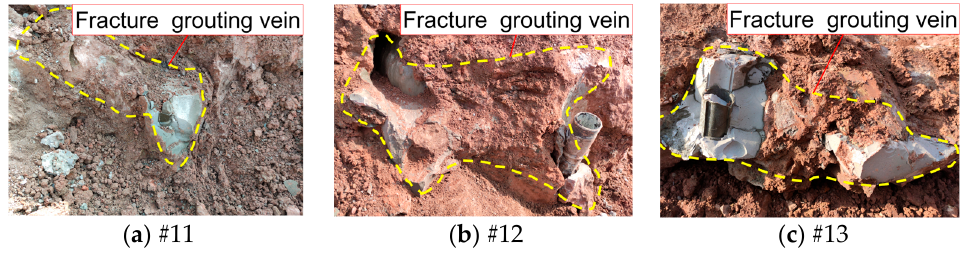
Figure 16. Concretion shape of groups #11–13.